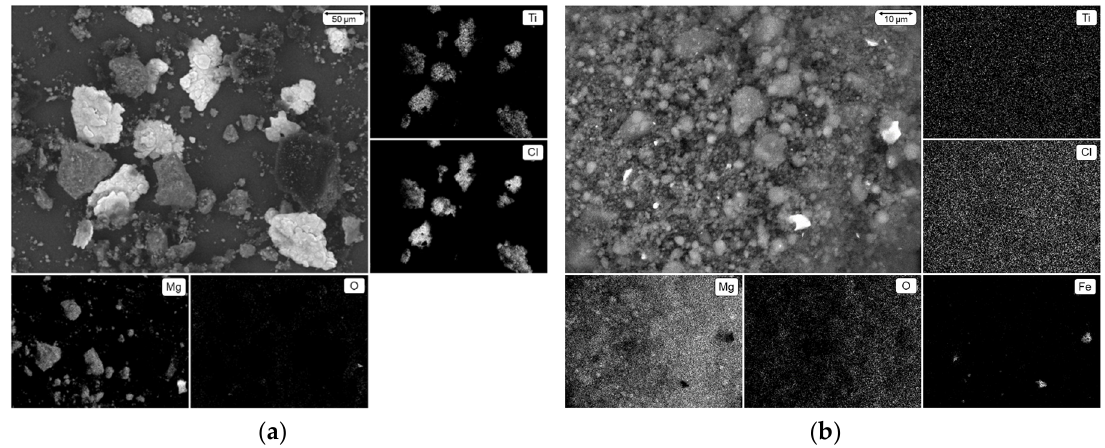
Figure 8. SEM backscattered electrons micrographs of the 2 LiH + MgB 2 + 0.025 TiCl 3 composite ( a ) for the unmilled sample, with EDX maps for Mg, O, Cl and Ti, and ( b ) for a sample milled at 330 rpm for 30 h with 50% of filling and a BPR of 5:1, with EDX analysis for Mg, O, Fe, Cl and Ti. Adapted from Reference [45], with permission of Elsevier, 2015.